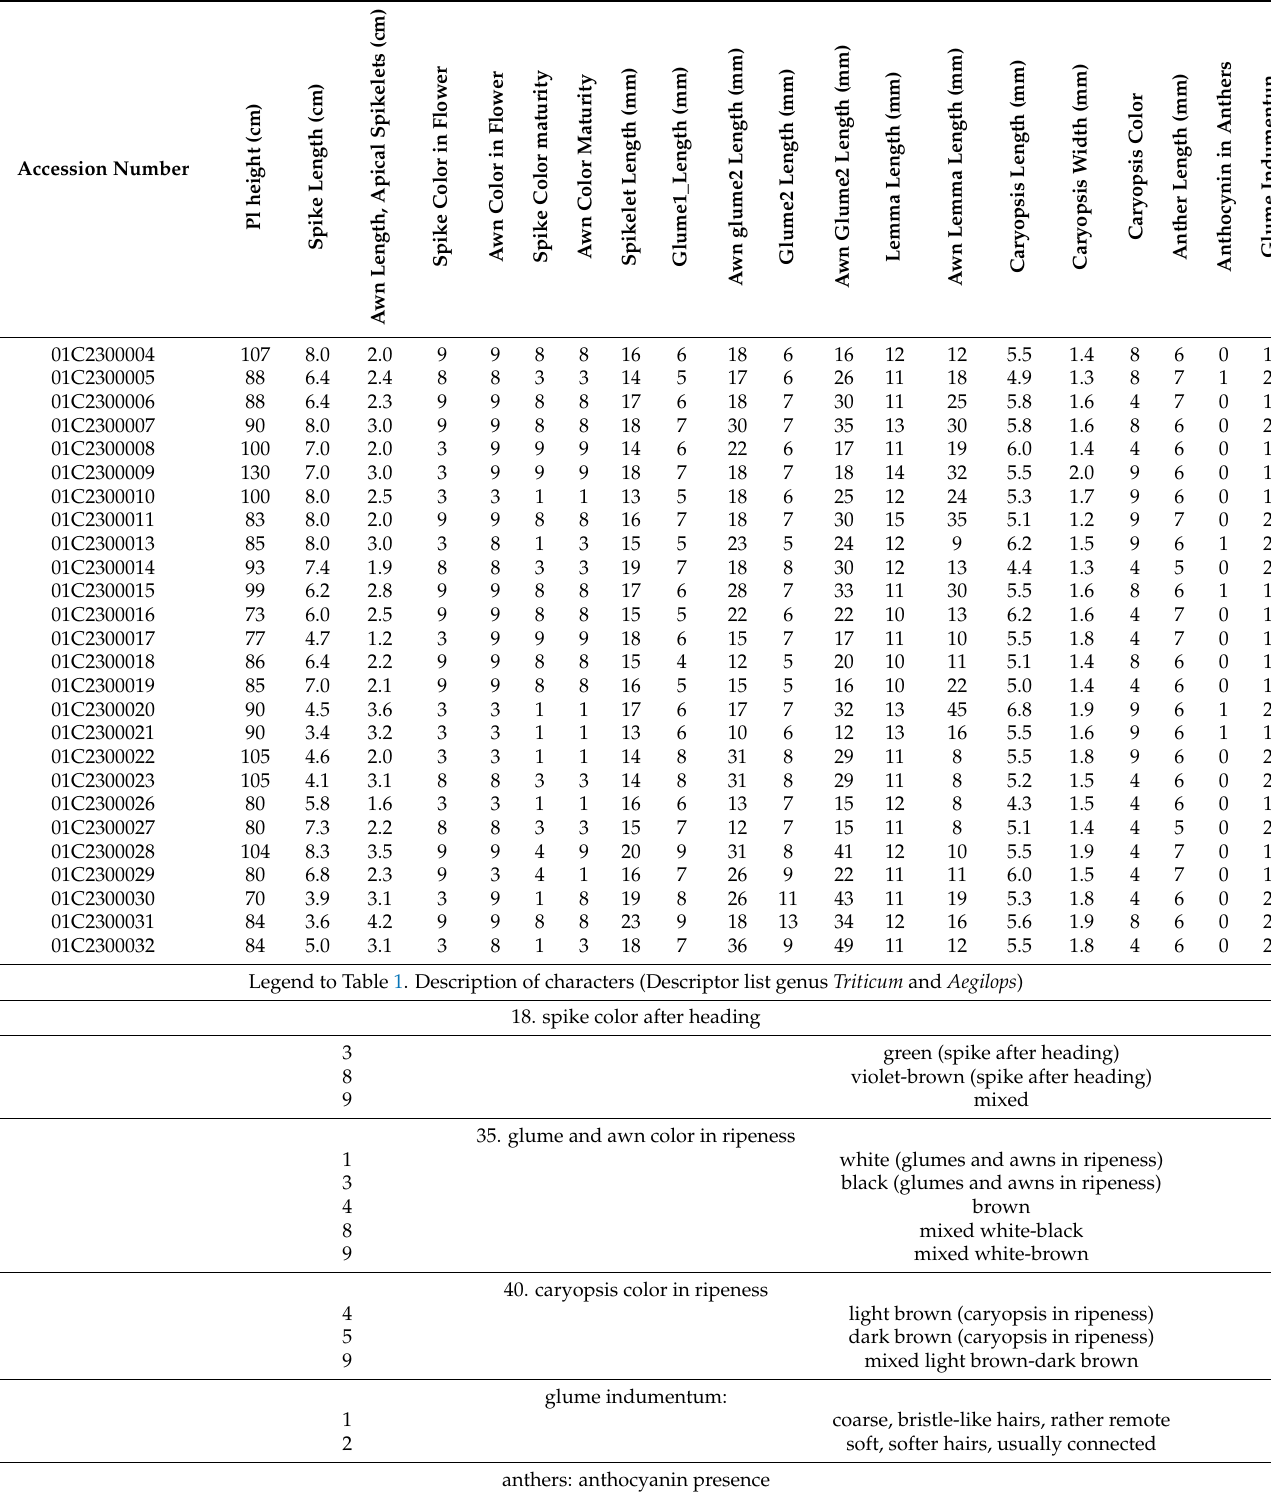
Table 1. Phenotyping of Dasypyrum villosum collection.